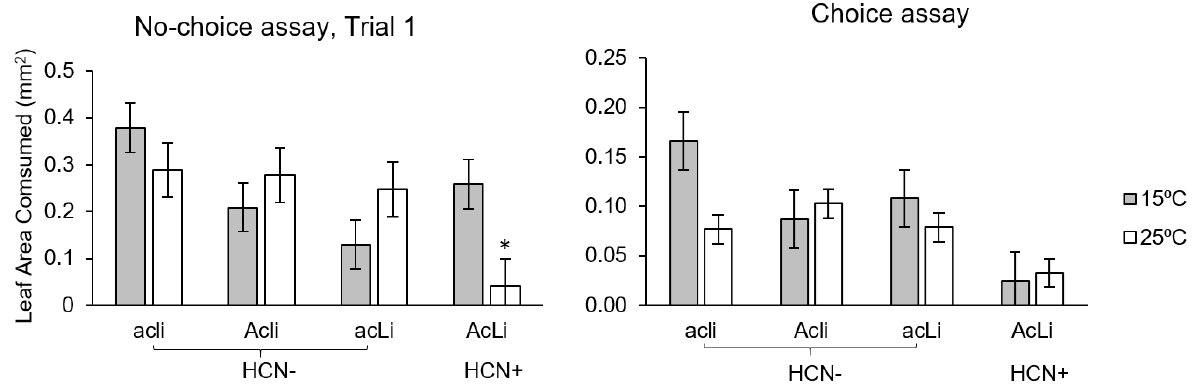
Figure 2. Slug herbivory on T. repens cyanotypes at different temperatures (N = 10 plants per cyanotype at each temperature). In the no-choice assay, D. reticulatum were offered one leaf of each cyanotype. In the choice assay, leaf material from all four cyanotypes was offered and herbivory was measured as leaf area consumed (mm 2 ) over a 24 h period. Bars represent means ± 1 SE. Asterisks (*) represent significant differences ( p < 0.05) within temperatures between cyanogenic (AcLi) and acyanogenic (average of Acli, acLi, and acli) plants based on custom contrasts (see Methods).